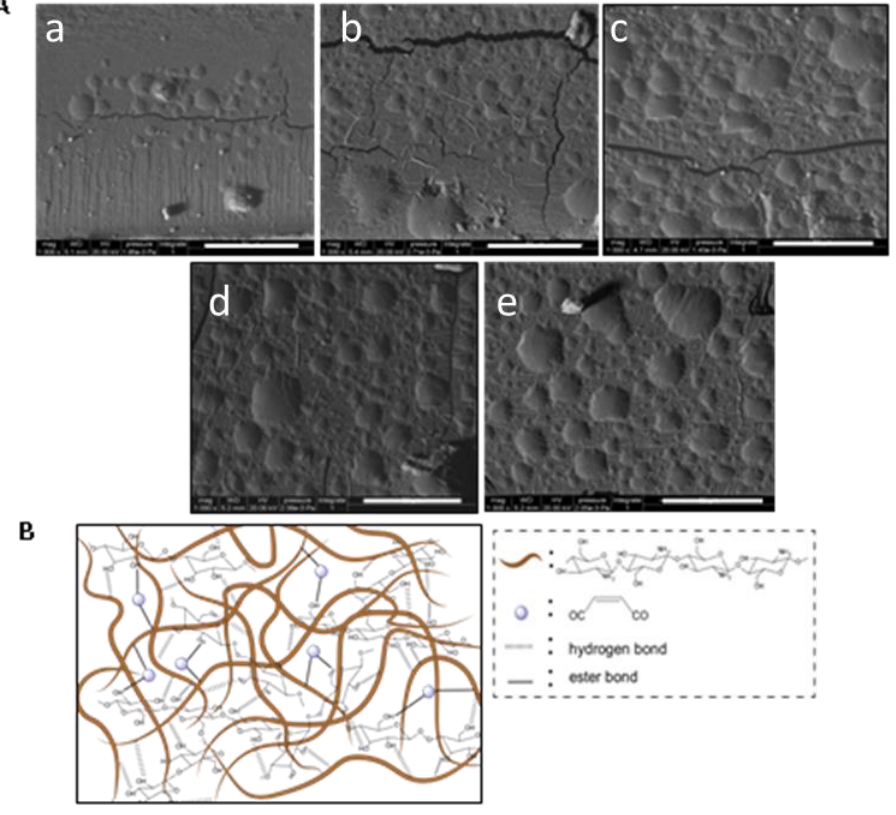
Figure 3. A . SEM photographs (1000× amplification) of starch film ( a ), S/CH 3% film ( b ), S/CH 7% film ( c ), S/MA-CH 3% film ( d ), S/MA-CH 7% film ( e ); B . illustrative scheme of S/MA-CH films. Scale bars indicate 50 μ m.